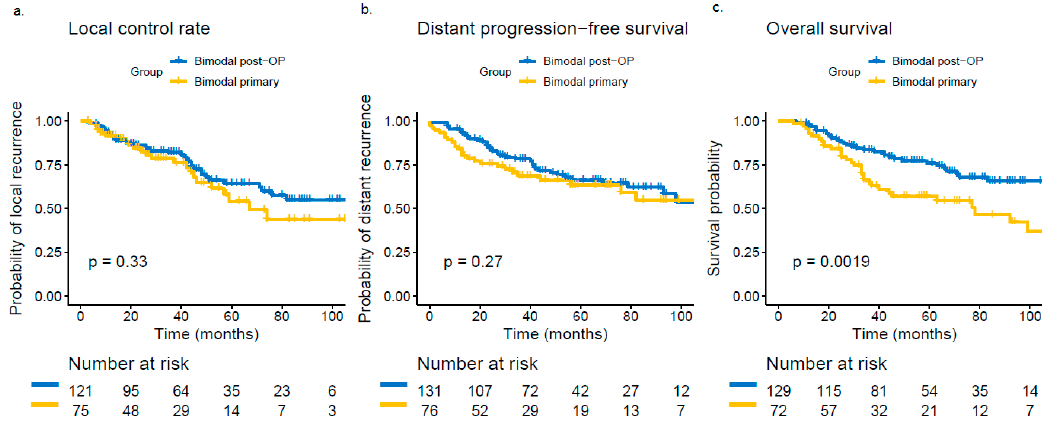
Figure 1. Kaplan-Meier estimates of local control ( a ., p = 0.33), distant progression-free survival ( b ., p = 0.27) and overall survival ( c ., p < 0.01) for primary and postoperative bimodal radiotherapy.